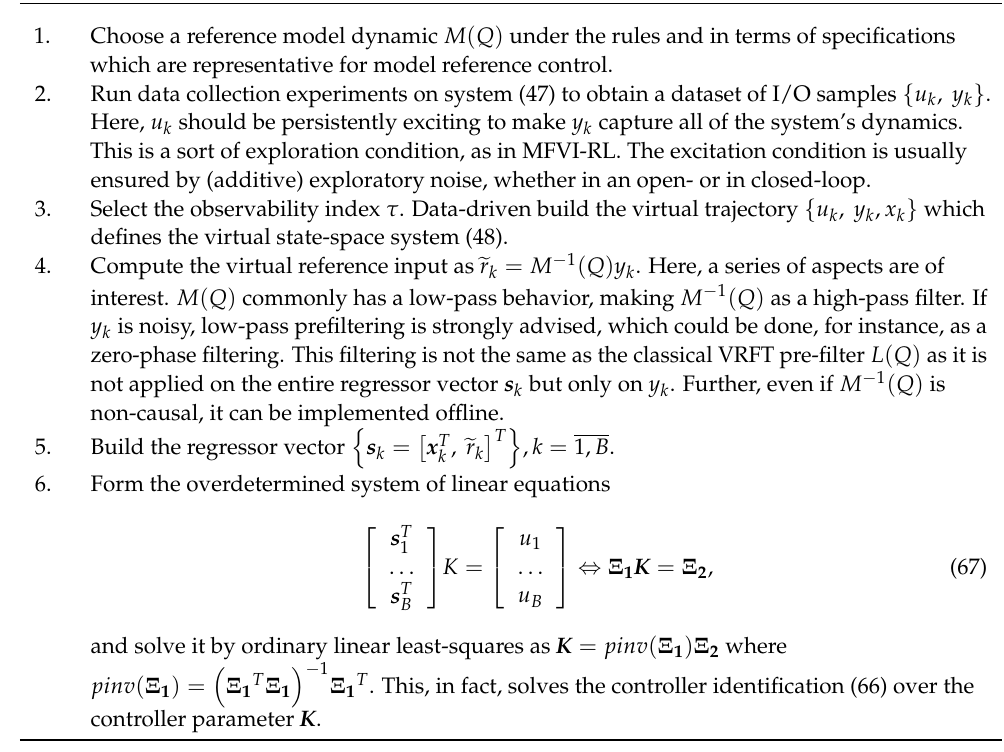
Algorithm 2. The VSFRT Algorithm 2 for ORM